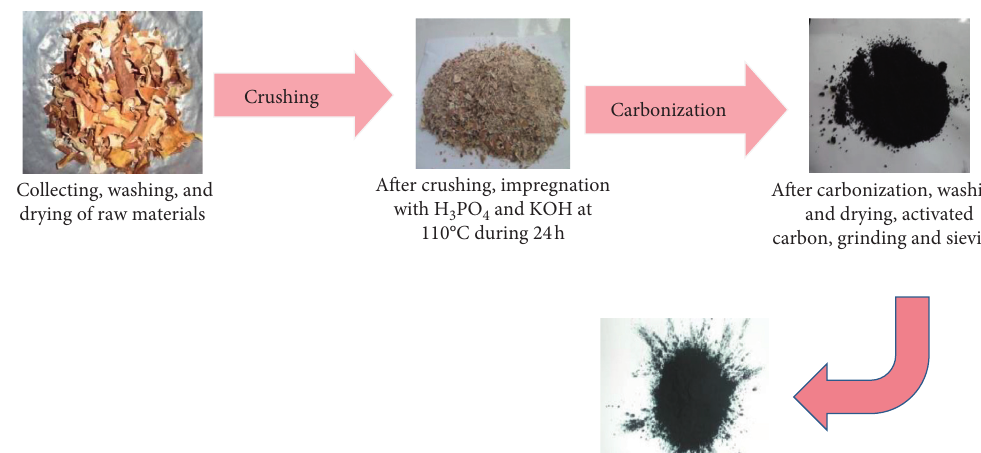
Figure 1: Step-by-step illustration of AC preparation from the peelings of cassava